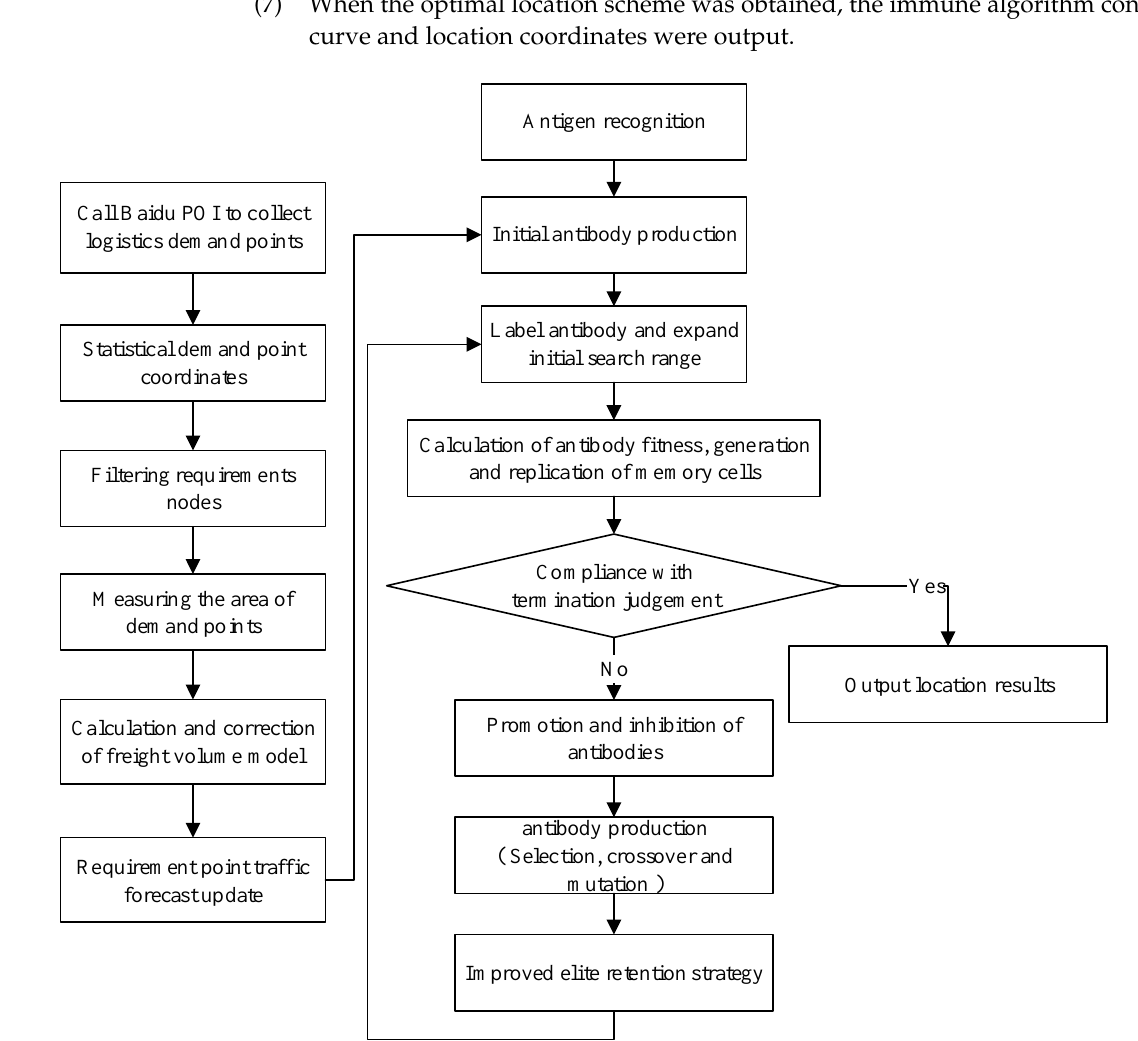
Figure 2. Flow chart of the improved immune optimization algorithm.